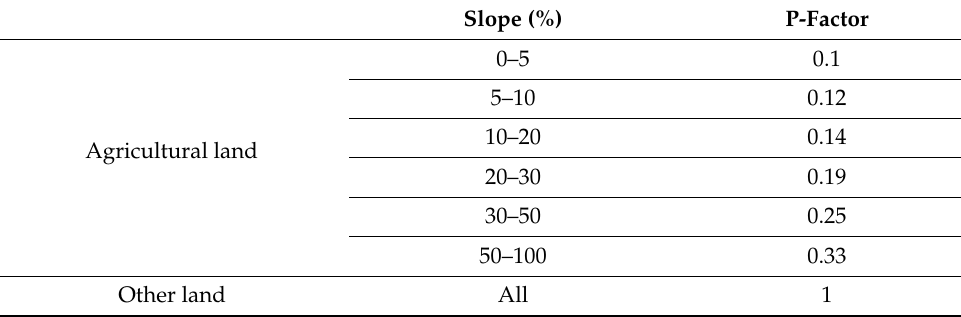
Table 3. P-factor reference values adopted from Wischmeier and Smith (1978)